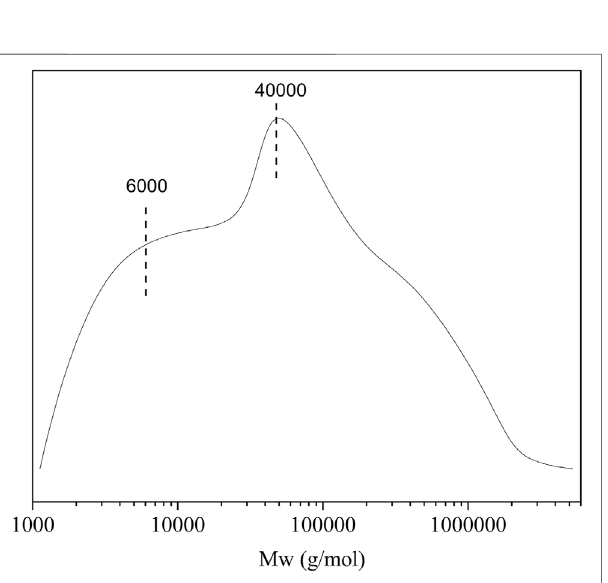
FIGURE 2 | The molecular weight distributions of CL